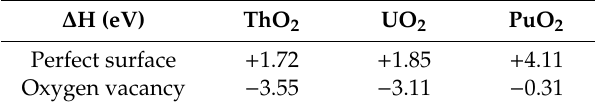
Table 7. The reaction energy of H 2 O splitting and H 2 formation (H 2 O  O* + H 2 ) on perfect ThO 2 , UO 2 , and PuO 2 (111) surfaces and corresponding surfaces with oxygen vacancies. A negative/positive value represents the reaction is exothermic/endothermic, respectively.